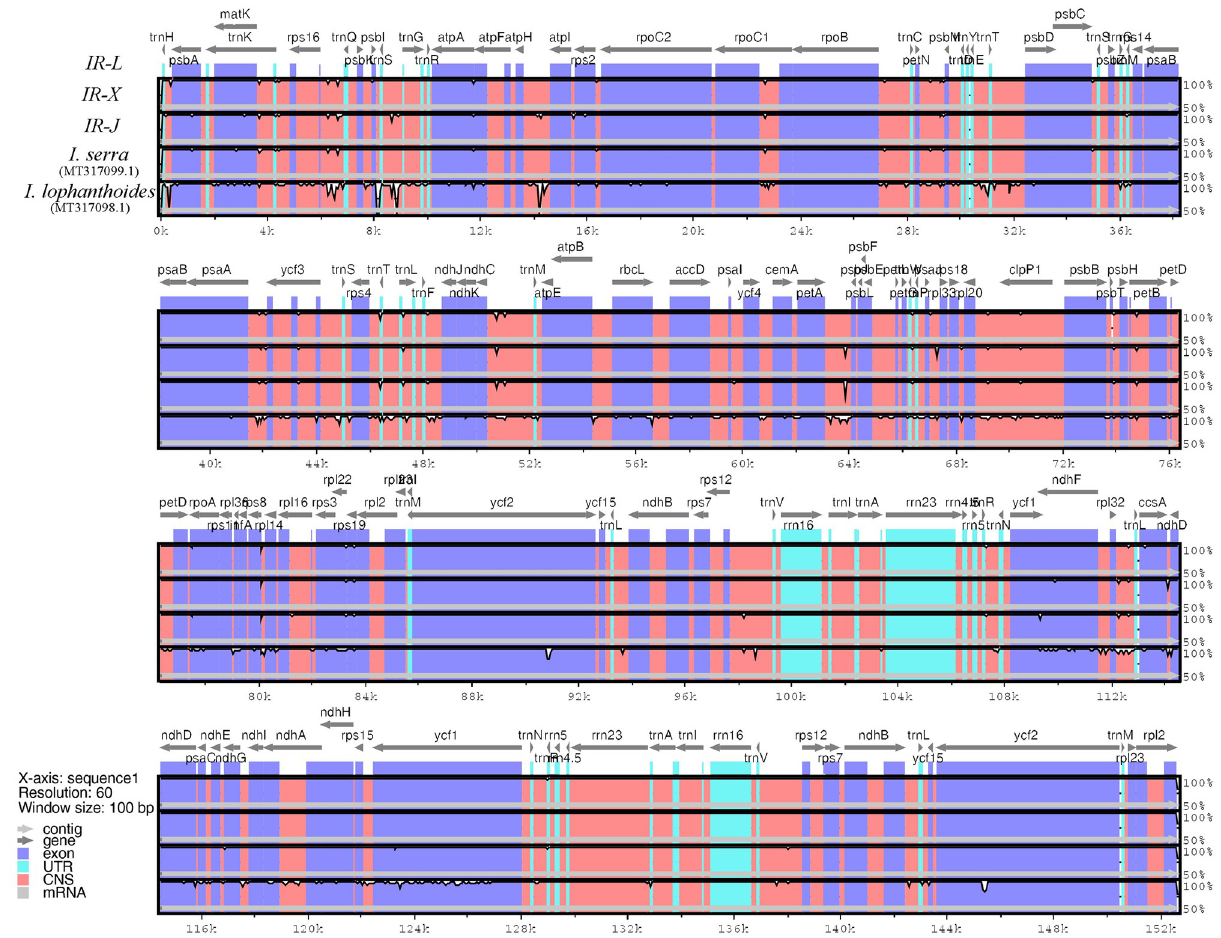
Fig 2. Sequence alignment of five Isodon chloroplast genomes using mVISTA. The annotation of I . rubescens ( IR-L ) was used as the reference. Gray arrows above the alignment indicate the position and direction of transcription of each gene. The scale on the vertical axes represents the percent sequence identity between 50% and 100%. IR-J , IR-X , and IR-L are the three accessions of I . rubescens